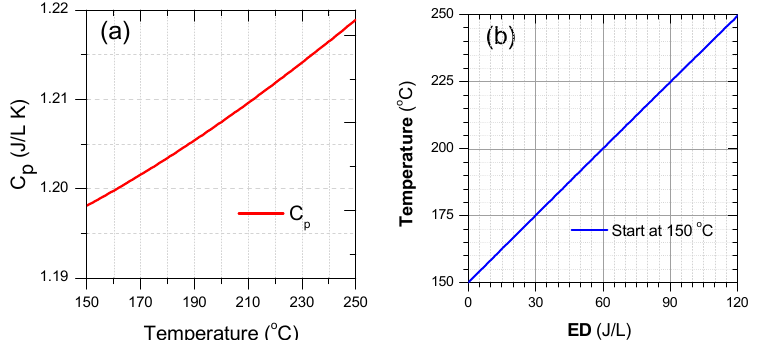
Figure 14. ( a ) C p of air with temperature from 150 °C to 250 °C and ( b ) air temperature as a function of ED with the initial temperate at 150 °C (C p and ED calculated with volume gas at 25 °C).